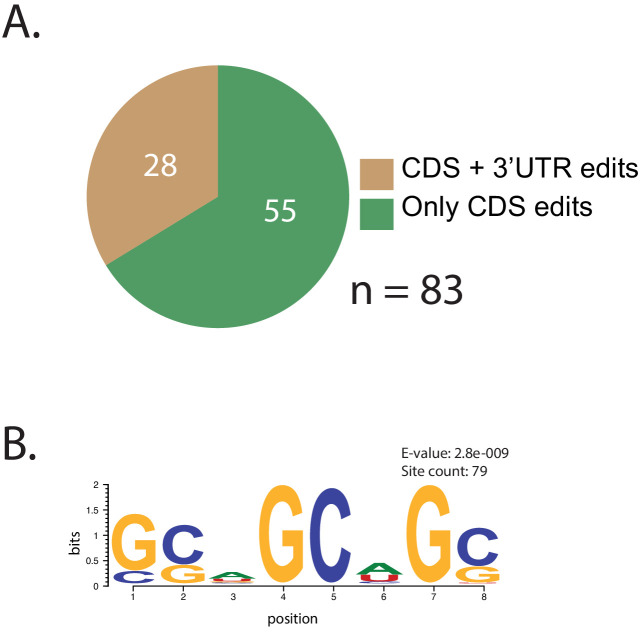
Coding sequence edits were co-existent with 3'UTR edits.(A) Coding sequence edits often occurred together with a 3′UTR edit on the same mRNA consistent with an initial Atx2–3′UTR interaction enabling edits to a proximal coding sequence as well. (B) A GC-rich motif for Atx2–CDS association indicated by analyses of sequences flanking CDS edit sites.